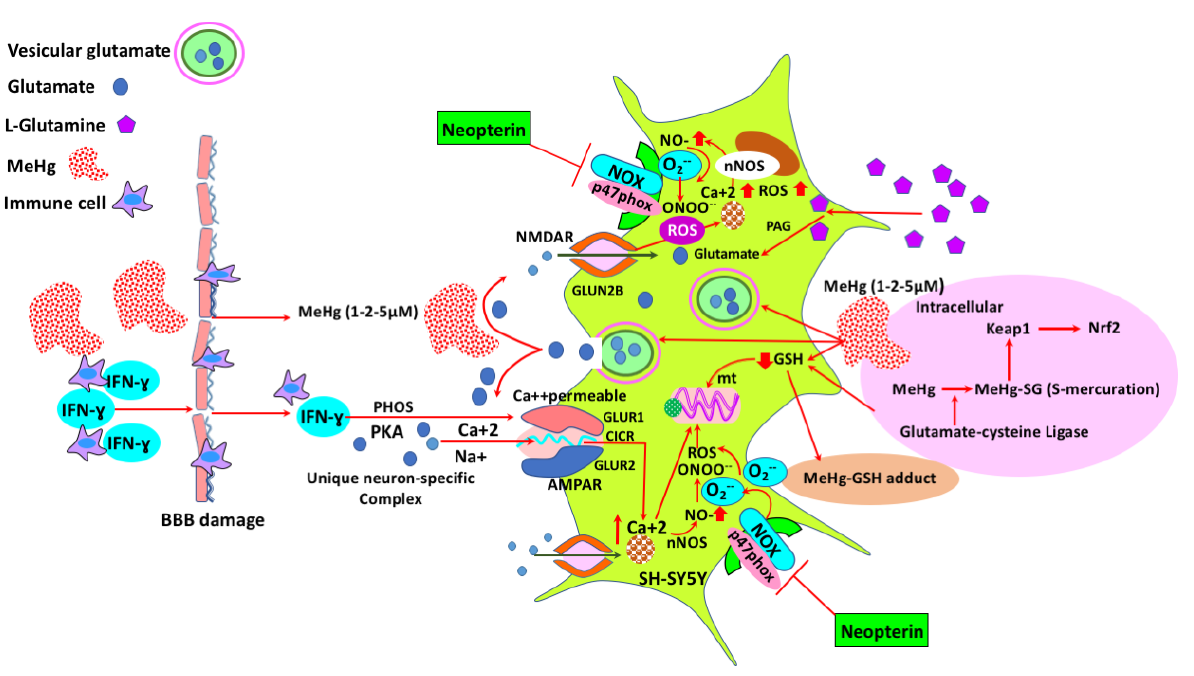
Figure 2: Mercury-induced neuronal death may occur via the glutamate-mediated excitotoxicity through NMDARs. Neopterin protects the SH- SY5Y dopaminergic neurons from glutamate-mediated toxic effect of MeHg. IFN-gamma sensitizes AMPAR complex of SH-SY5Y dopaminergic neurons and alters the protective effect of neopterin on neuronal toxicity of MeHg. Glutamate is indispensible mediator of MeHg and neopterin effects ( MeHg: Methyl mercury, PAG: Phosphate activated glutaminase GSH: Reduced glutathione NMDAR: N-methyl-D-aspartate